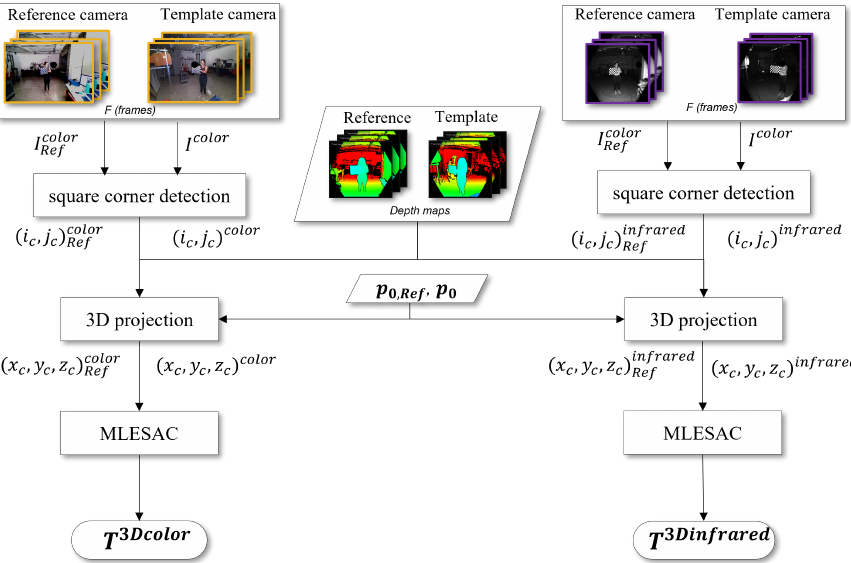
Figure 5. 3D calibration flow chart for the creation of the transformation matrices T 3 Dcolor and T 3 Dinfrared . The frames with color resolution are marked in yellow, while the frames with infrared resolution are marked in